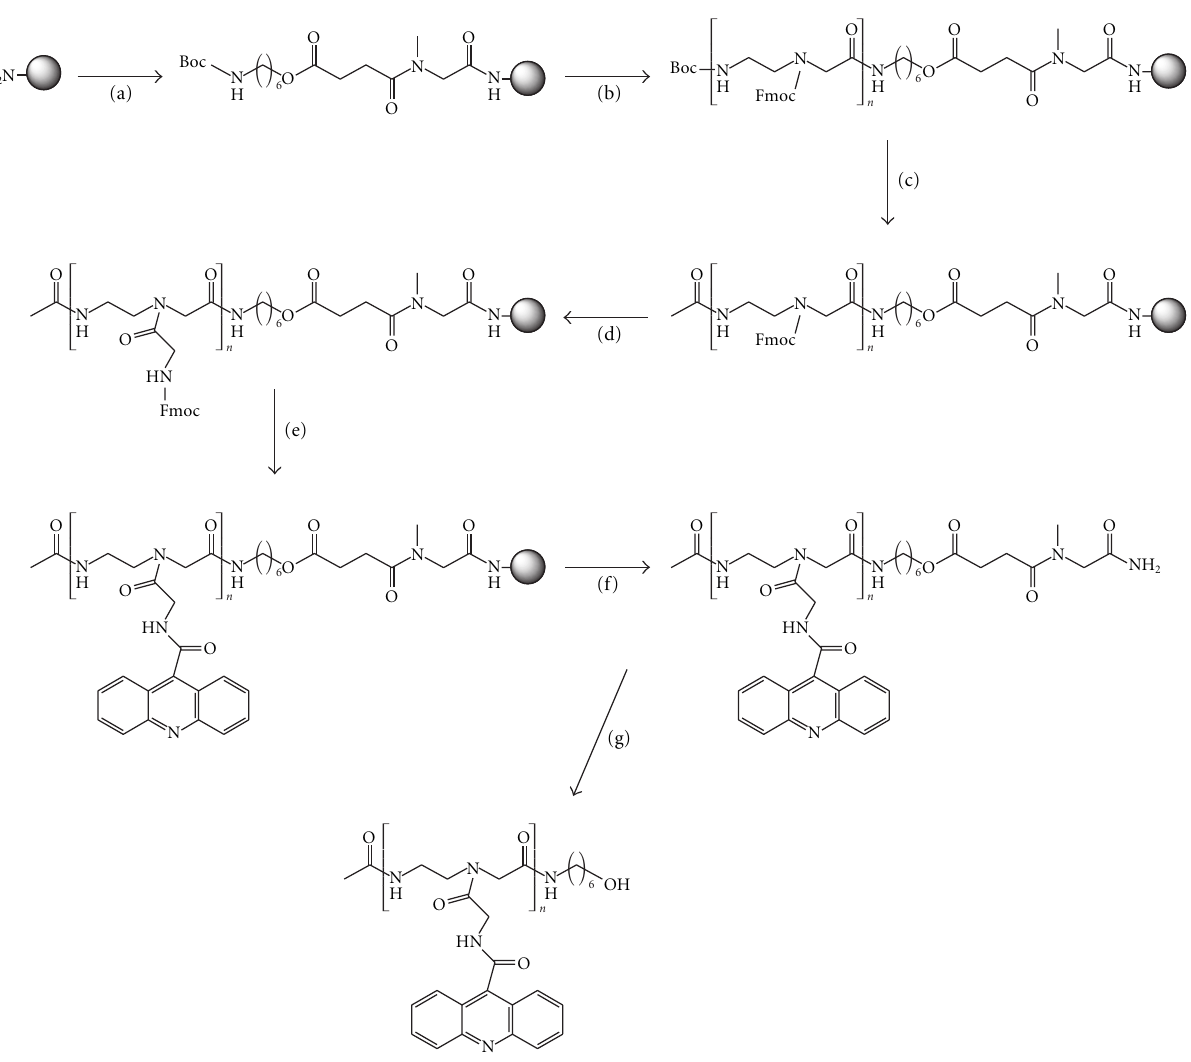
Figure 2: Solid-phase synthesis of dimer and trimer acridine derivatives. (a) (i) Fmoc-Sar-OH, PyBOP, DIEA; (ii) 20% piperidine,